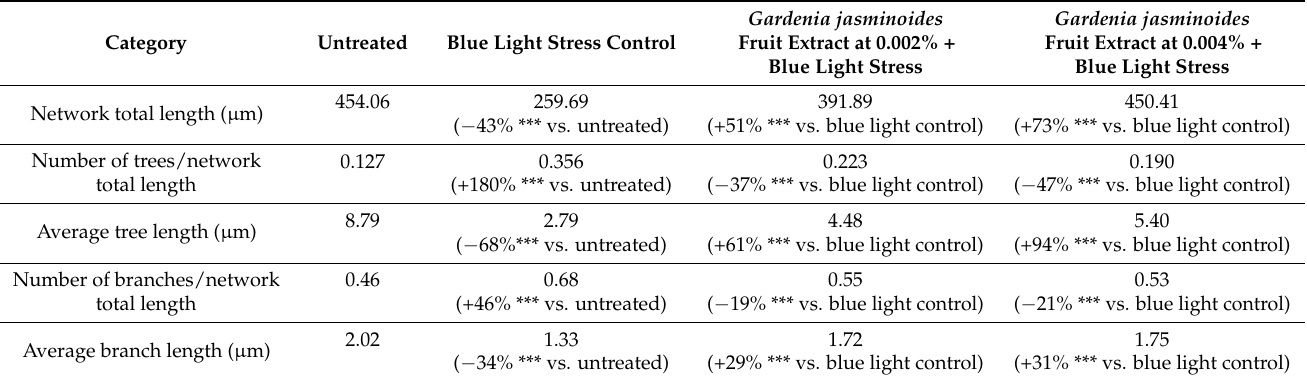
Table 1. Network characterization and quantification. Significance was defined by a one-way ANOVA, followed by Dunnett’s multiple comparison test with a single pooled variance, where *** indicates p <